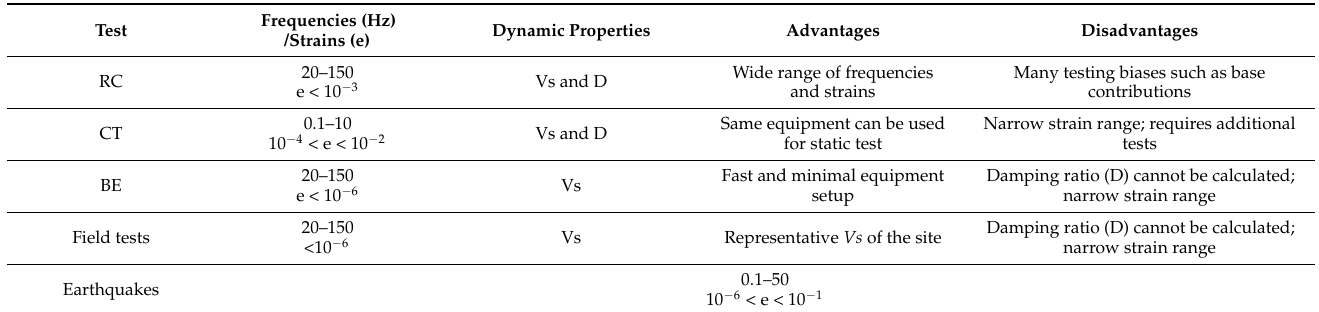
Table 1. Characteristics of RC, CT, BE, and field tests.